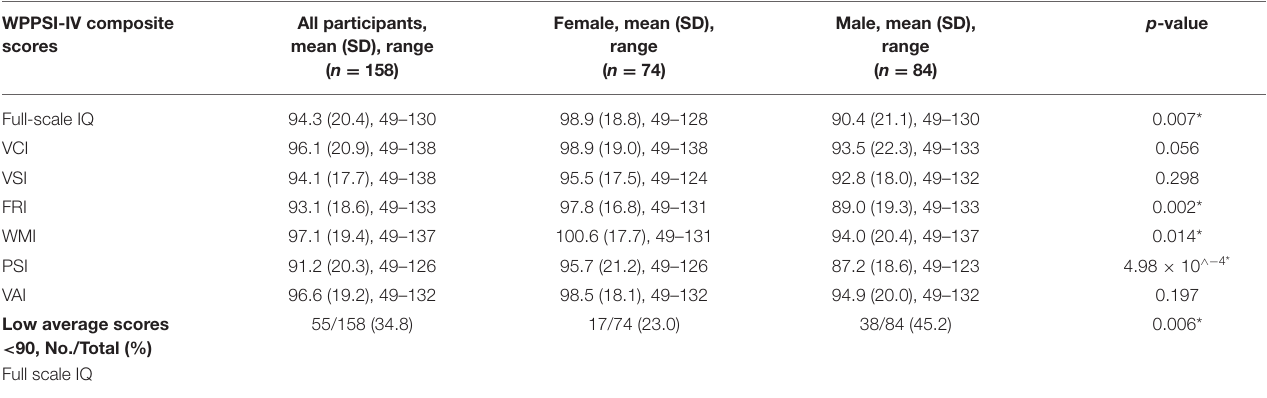
TABLE 2 | WPPSI-IV composite scores for 5-year-old children born VLBW. WPPSI-IV composite